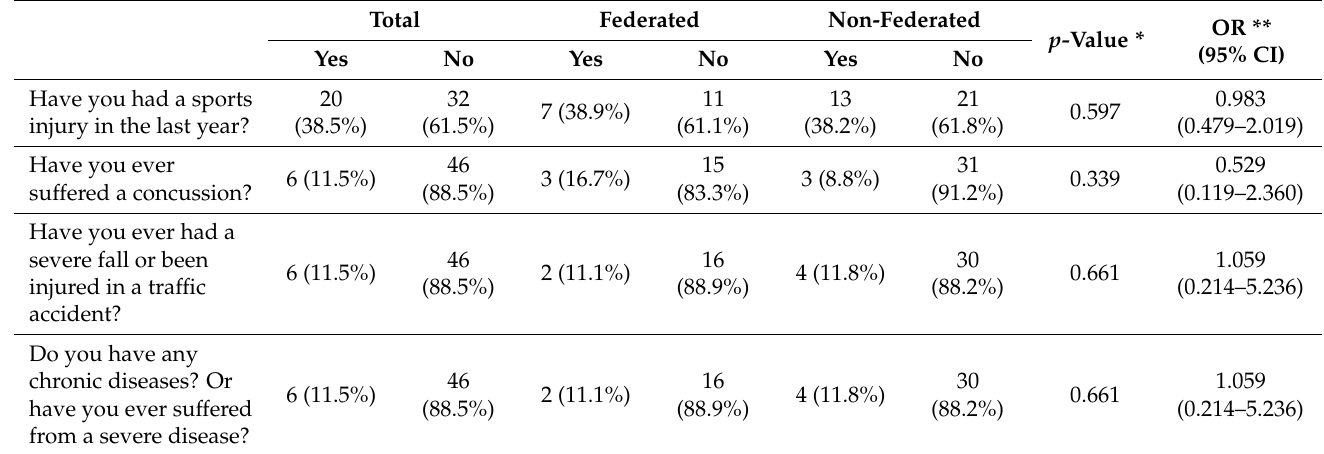
Table 2. Athletes regarding injuries or accidents give the answers.